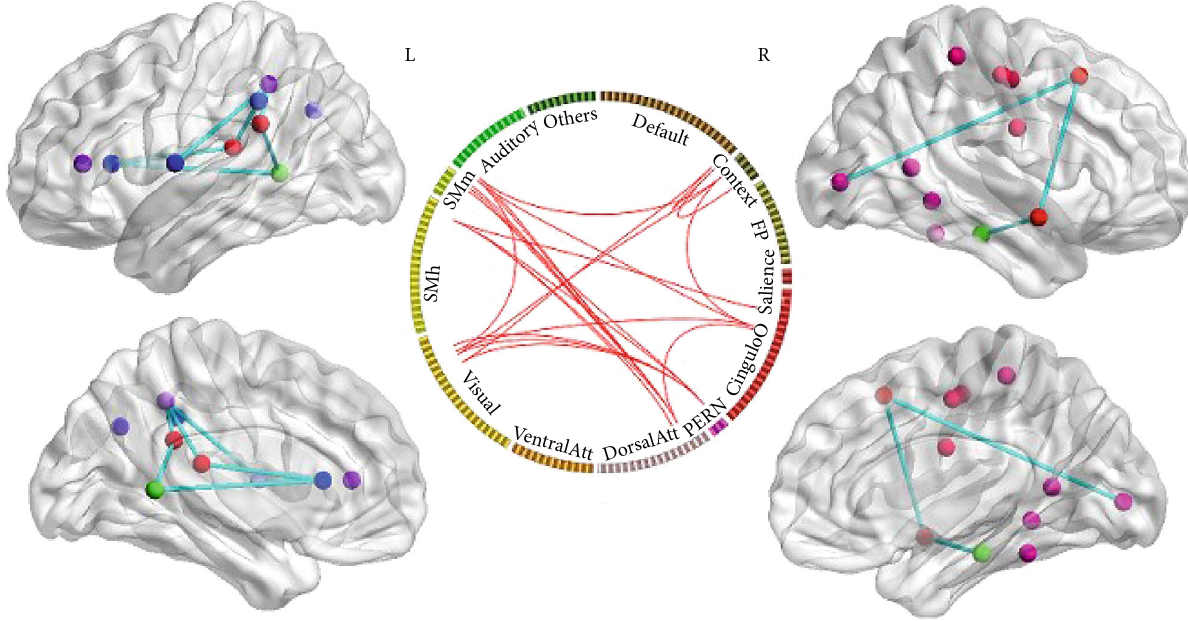
Figure 3: Two-dimension and three-dimension depictions of connectivity analysis result in the WM versus FIX condition. WM: working